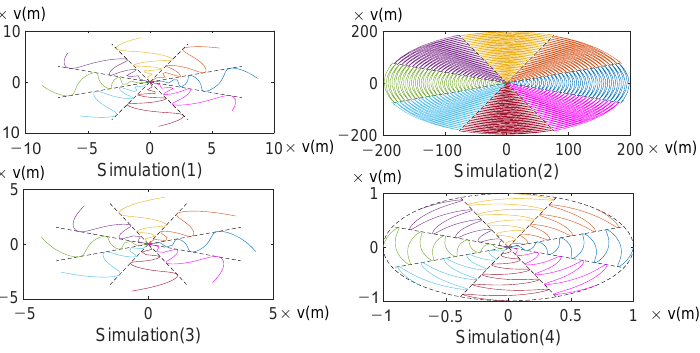
Figure 2. The motion trajectories of 8 agents.